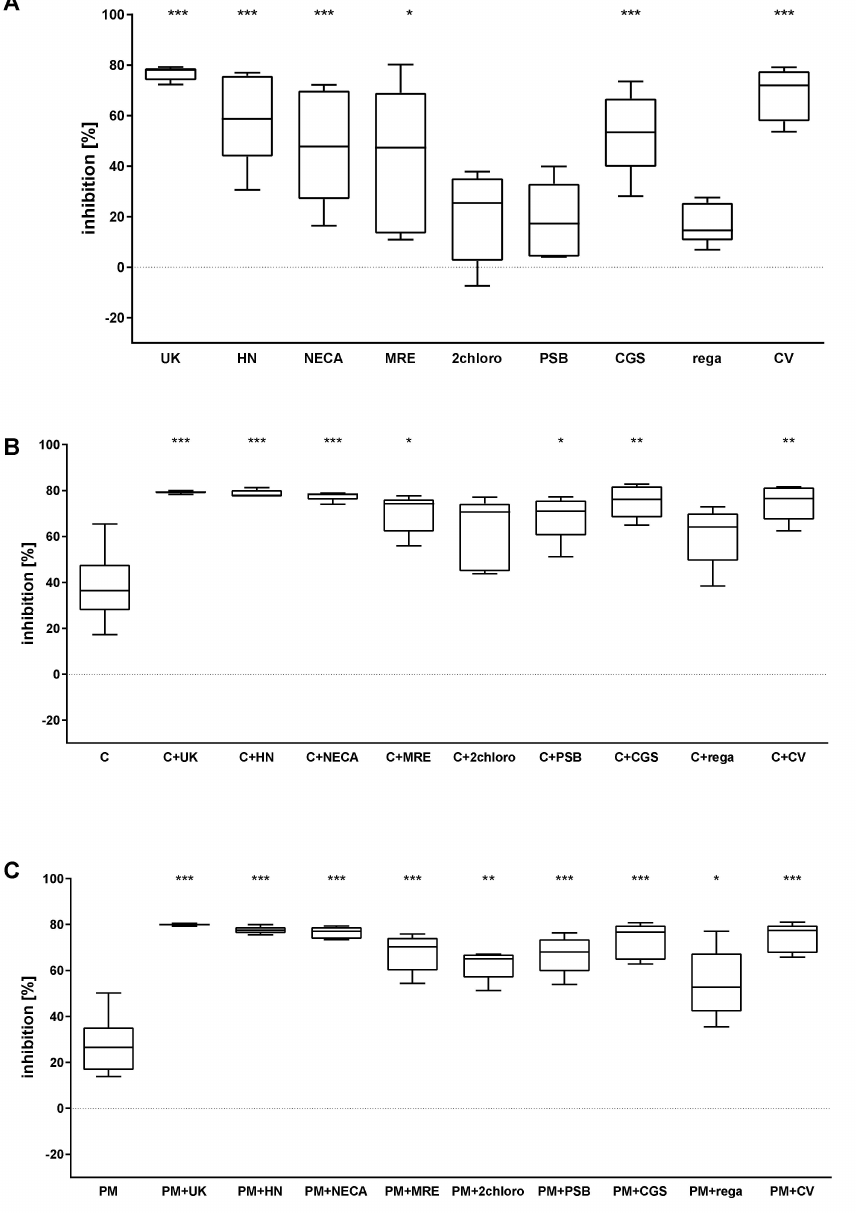
Figure 5. AR agonists strengthen the inhibitory e ff ect on calcium ion mobilisation by of P2Y 12 antagonists ( n = 5). Panels present data on the e ff ect of AR agonist on platelets ( A ), platelets antagonised with P2Y 12 inhibitor: cangrelor ( B ) or prasugrel metabolite (PM) ( C ). Data are presented as